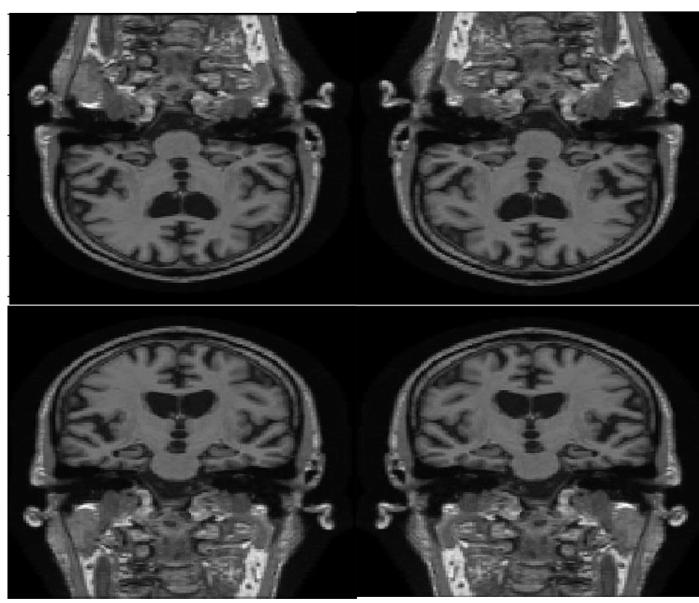
Figure 6. Sample image flips. Above, original, and horizontal flip.